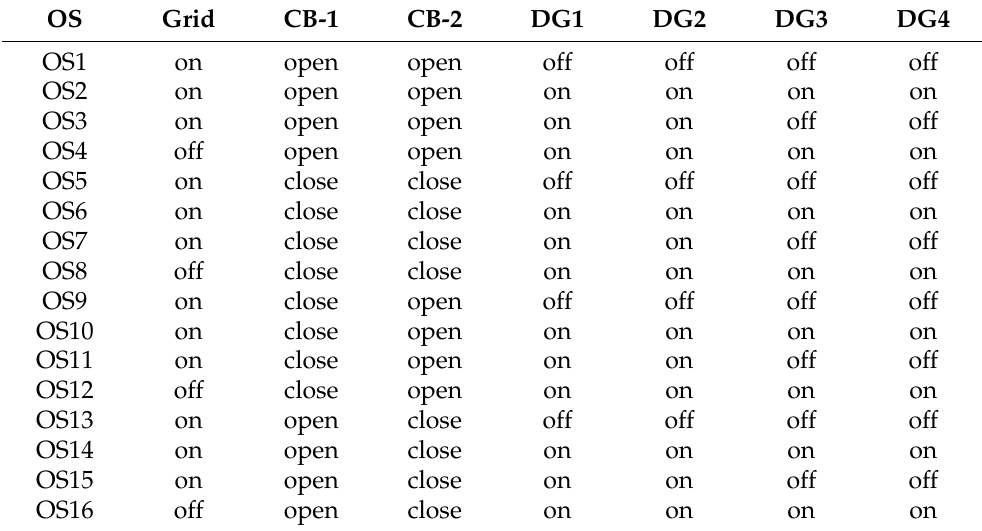
Table 2. Microgrid operative